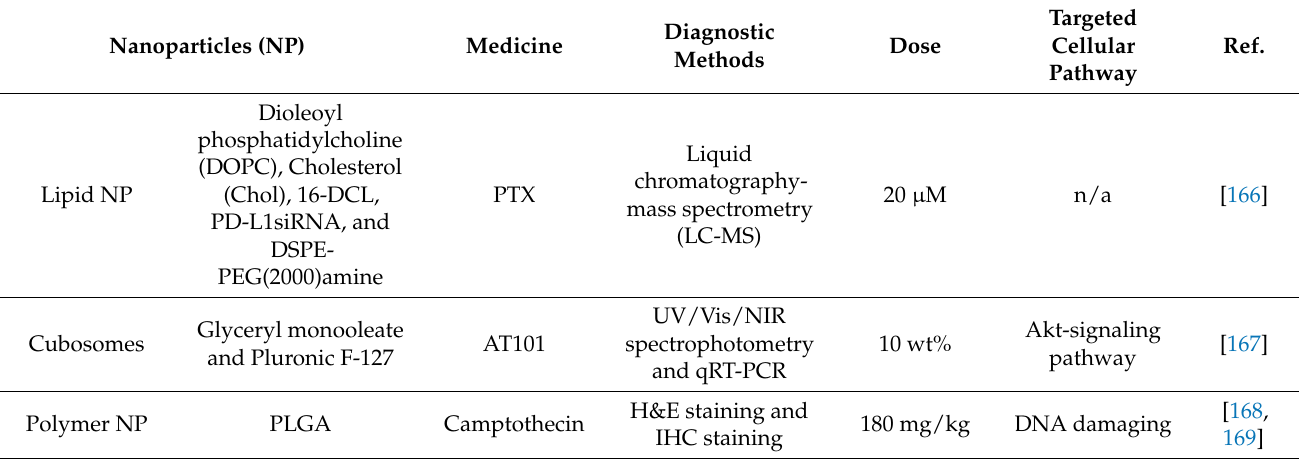
Table 3. Chemotherapy applied in glioblastoma treatments with different